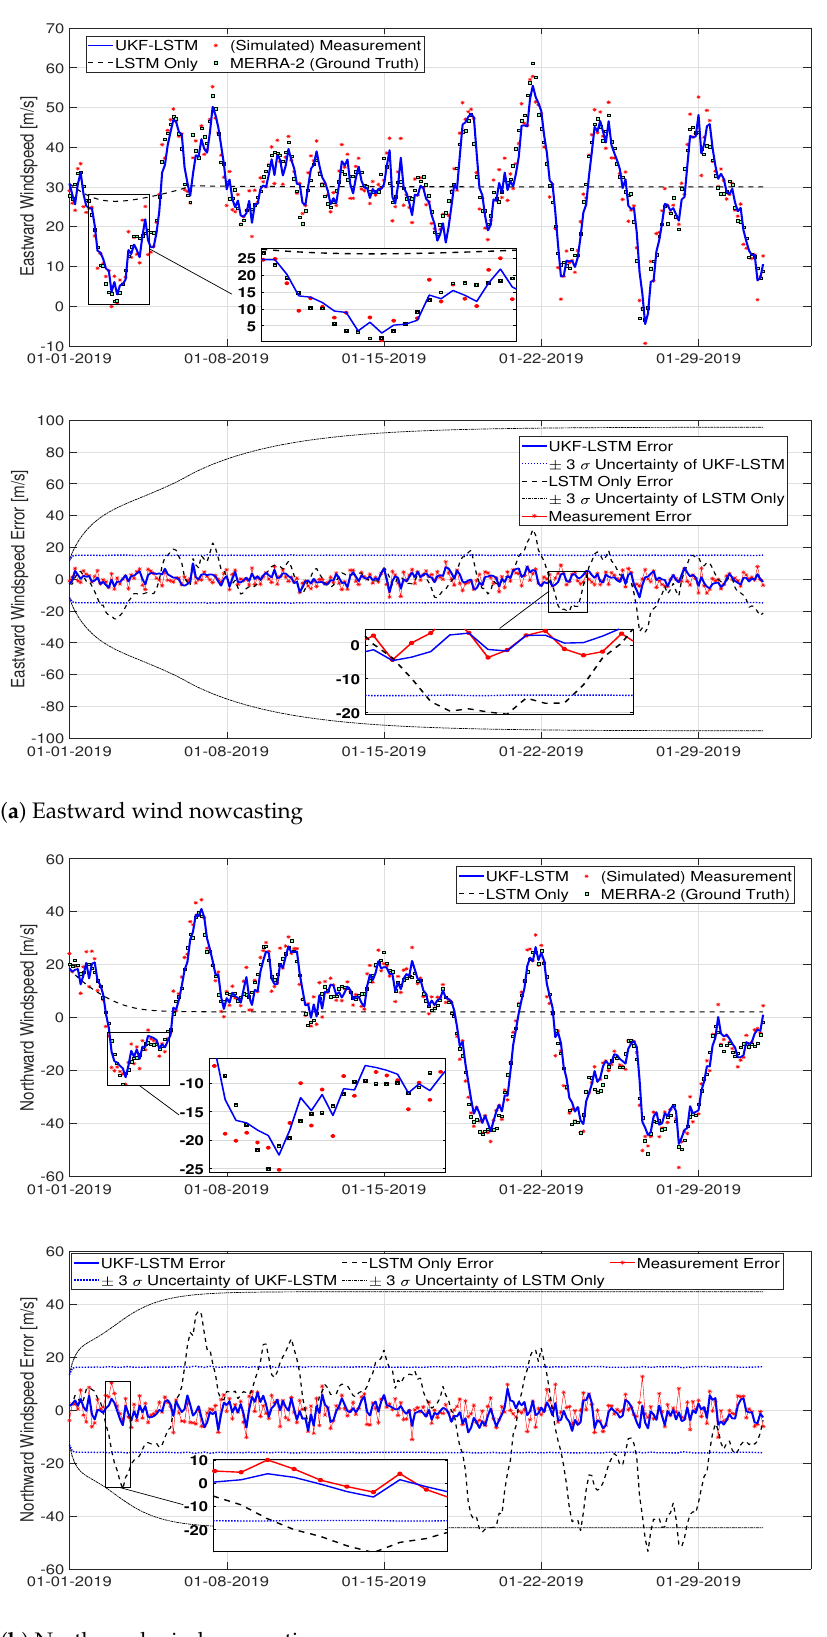
Figure 8. Performance comparison of wind nowcasting approaches (i.e., UKF-LSTM vs. LSTM only) to the test datasets (2019